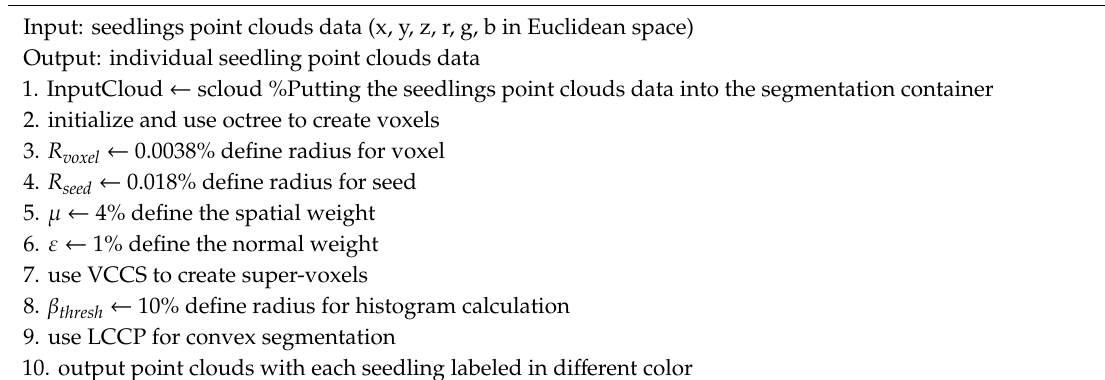
Figure 6. Segmentation in different stages: ( a ) colored point clouds; ( b ) super-voxels; ( c ) segments. Parameters: R voxel = 0.0038, R seed = 0.0018, and β thresh = 10 ◦ . The partition of individual seedlings with VCCS and LCCP methods is shown in Algorithm 3. Algorithm 3. Segmenting individual seedlings with Voxel Cloud Connectivity Segmentation (VCCS) and Locally Convex Connected Patches (LCCP) of seedling point